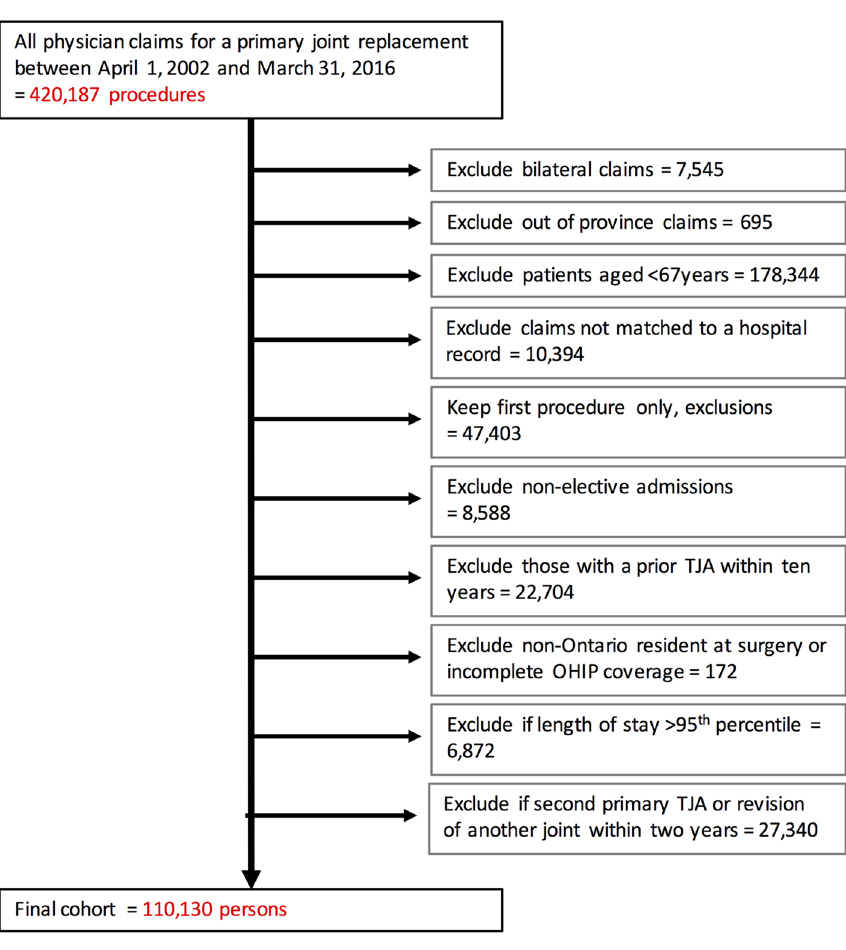
Figure 1. Assembling the study